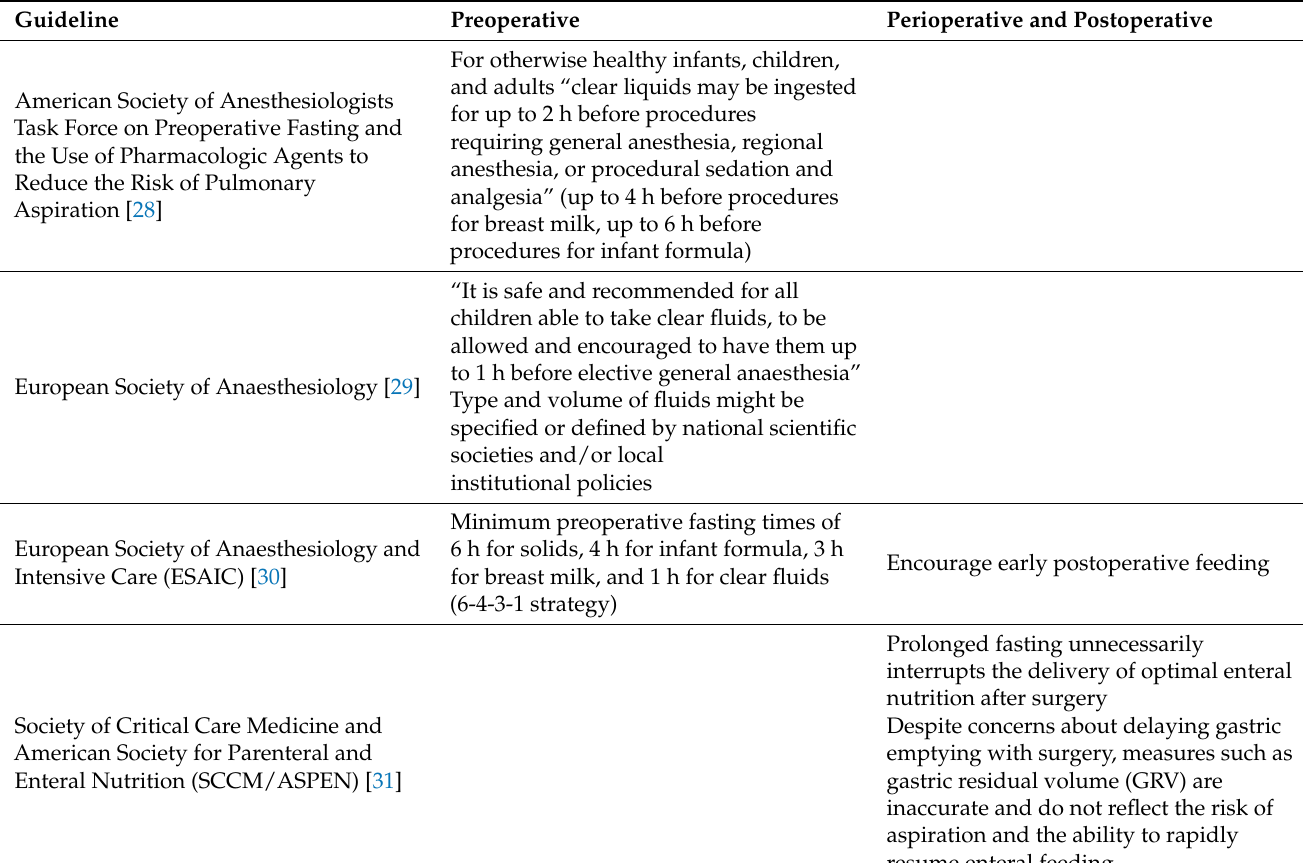
Table 3. Current Guideline Recommendations on Preoperative Fasting in Pediatric Patients Undergo- ing